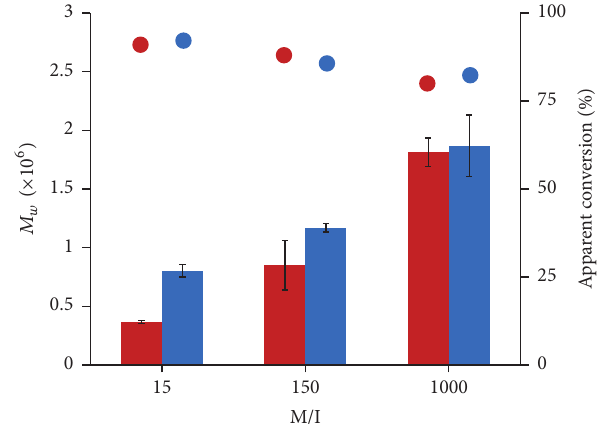
Figure 4: Weight-averaged molecular weight (bars) and apparent conversion (circles) fortheAIBN-initiated (redcolor)deoxygenated and (blue color) control admicellar polymerizations of styrene at M/I values of 15, 150, and 1000. Control samples at M/I = 1000 did not generate enough polymer for SEC analysis.